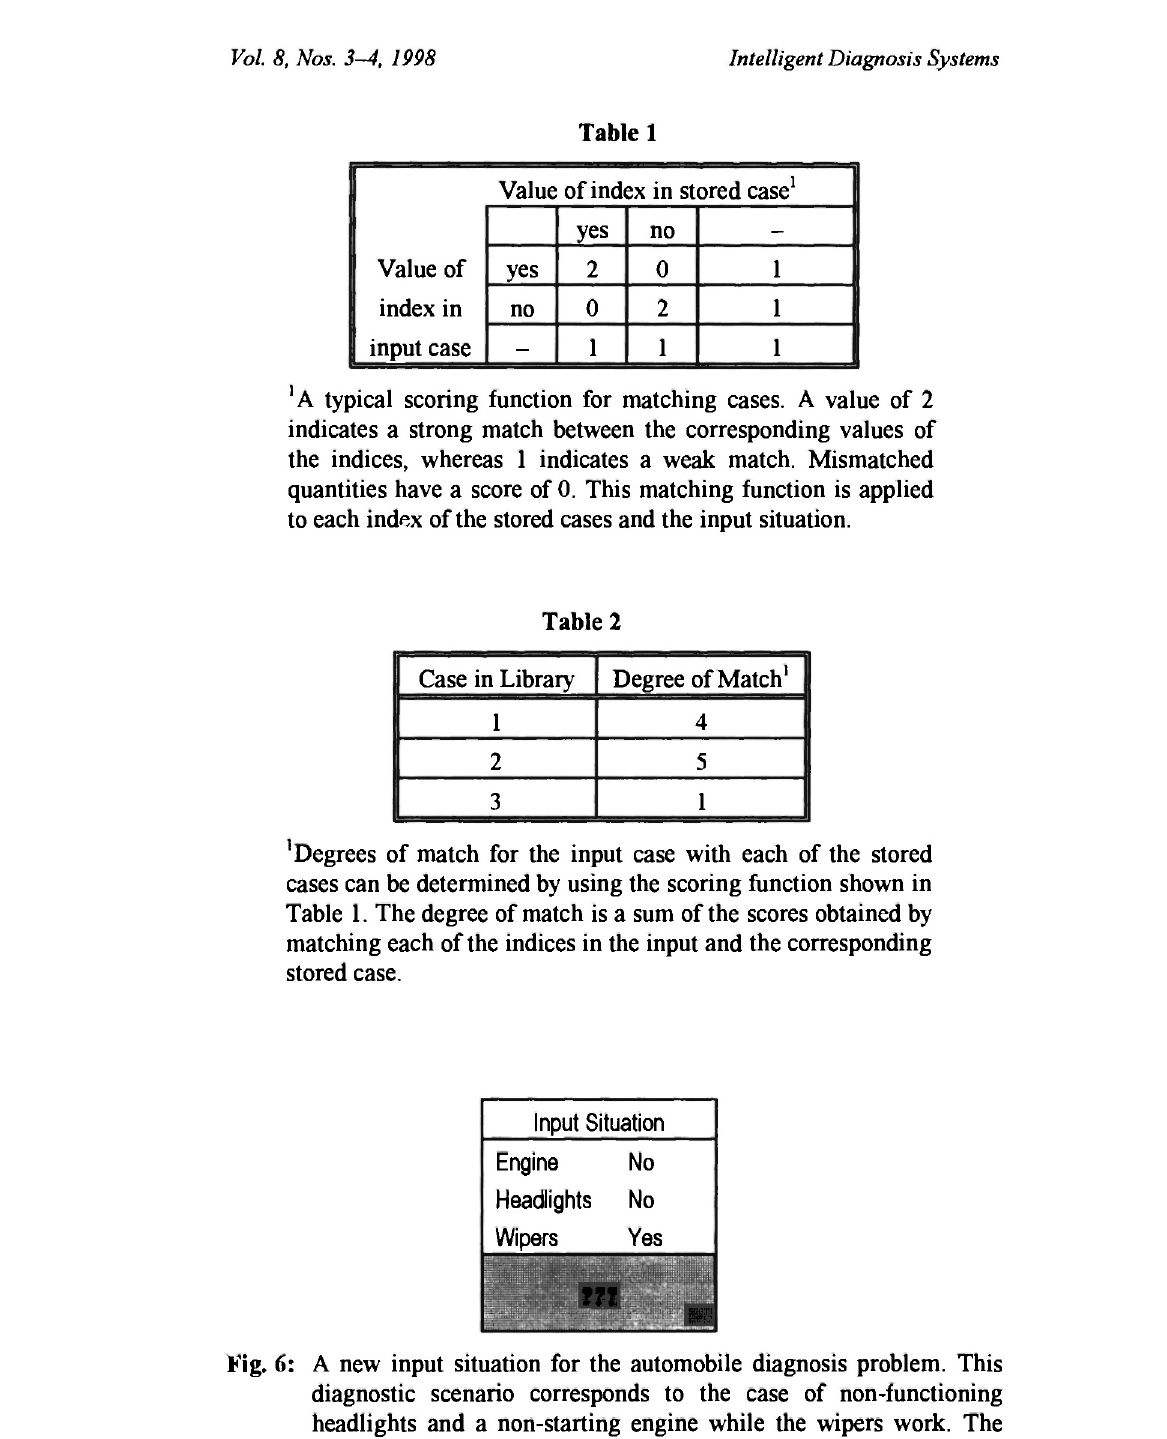
Fig. 6: A new input situation for the automobile diagnosis problem. This diagnostic scenario corresponds to the case of non-functioning headlights and a non-starting engine while the wipers work. The CBR system is expected to produce a diagnosis for this